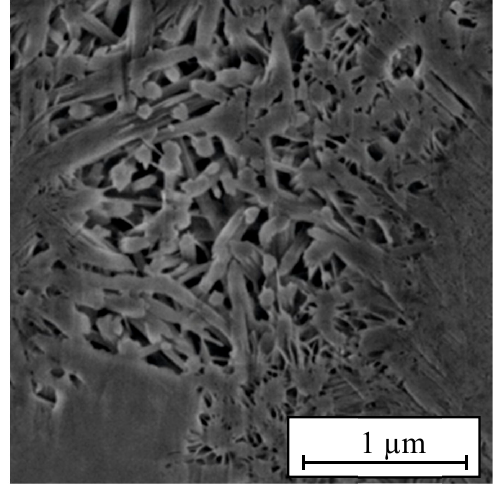
Figure 5. SEM image of C-S-H [37].